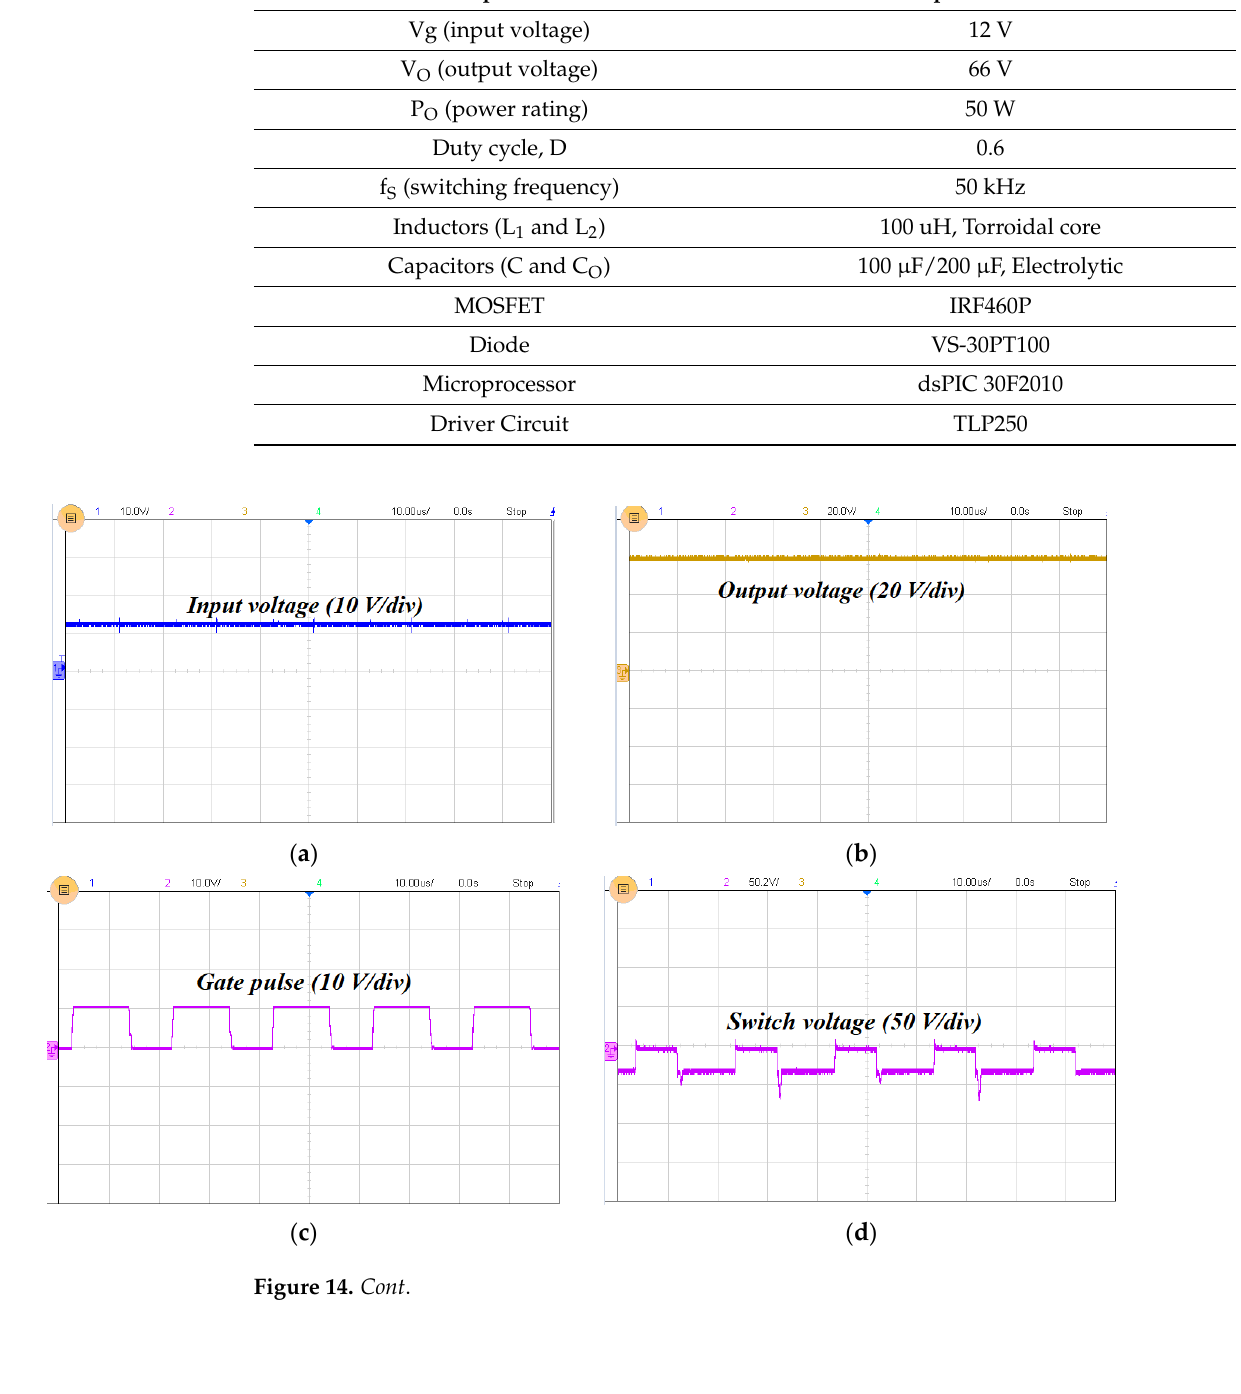
Table 5. Specification and components for experimental setup.